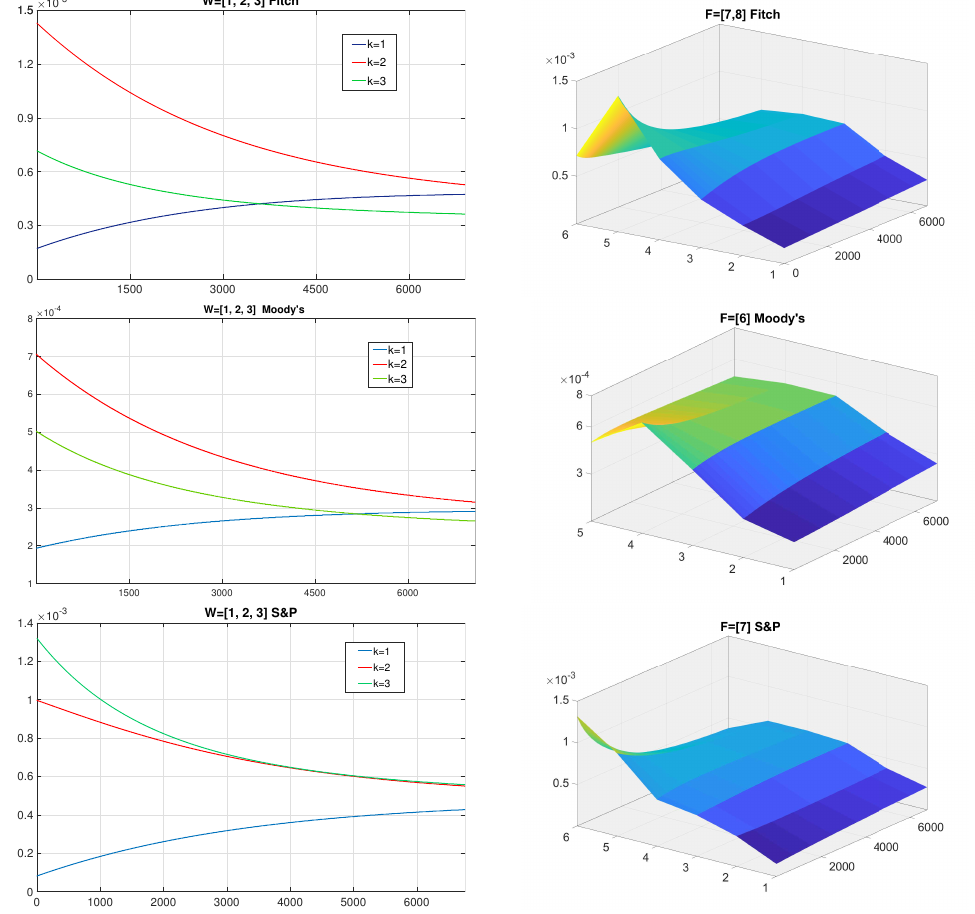
Figure 3. Rate of Occurence of Failures for all Agencies.